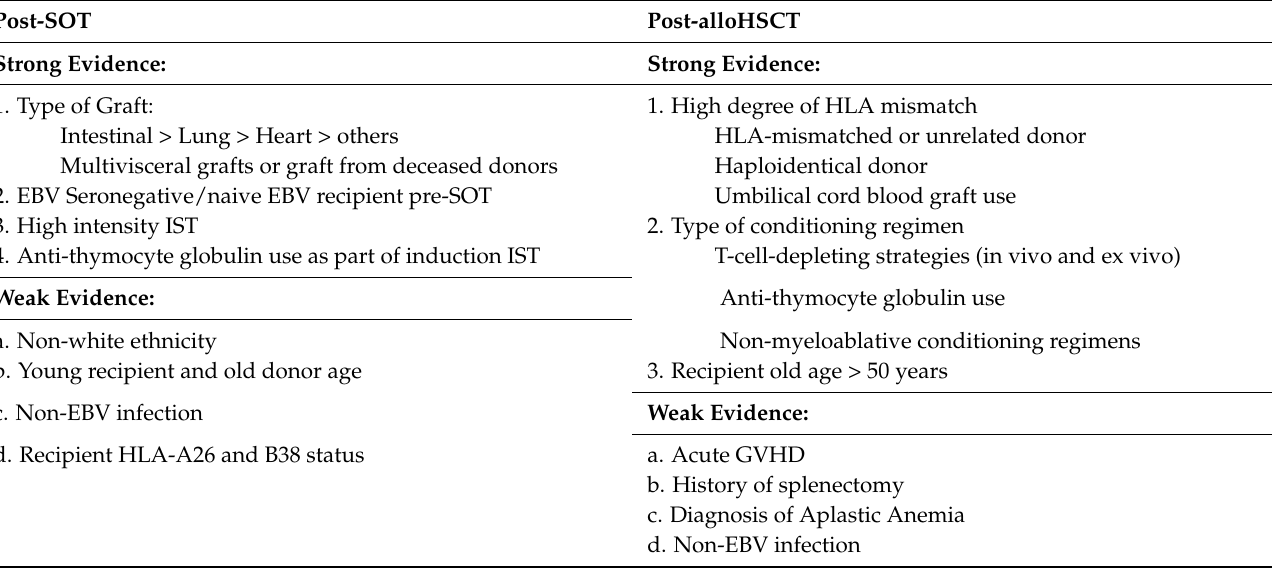
Table 2. Risk factors for